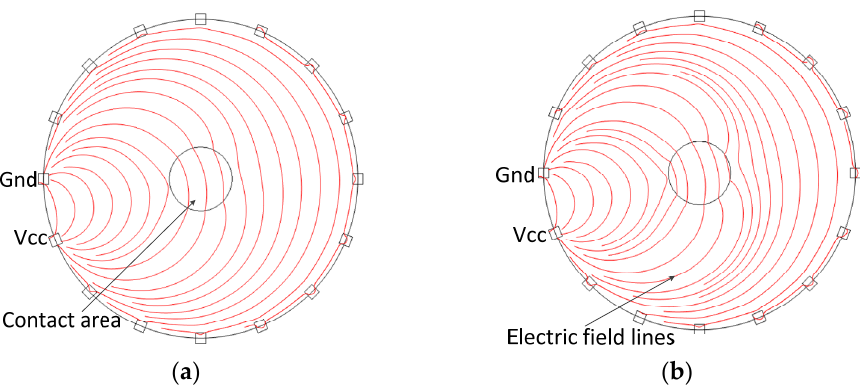
Figure 2. Current density comparison: ( a ) single-layer structure; ( b ) two-layer structure.